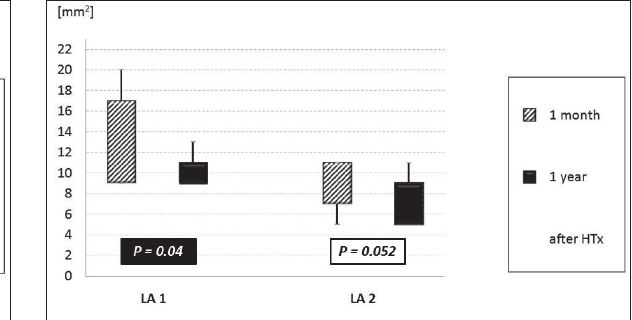
Fig. 5. DTA progression over one year = LA1 + LA2 LA = lumen area